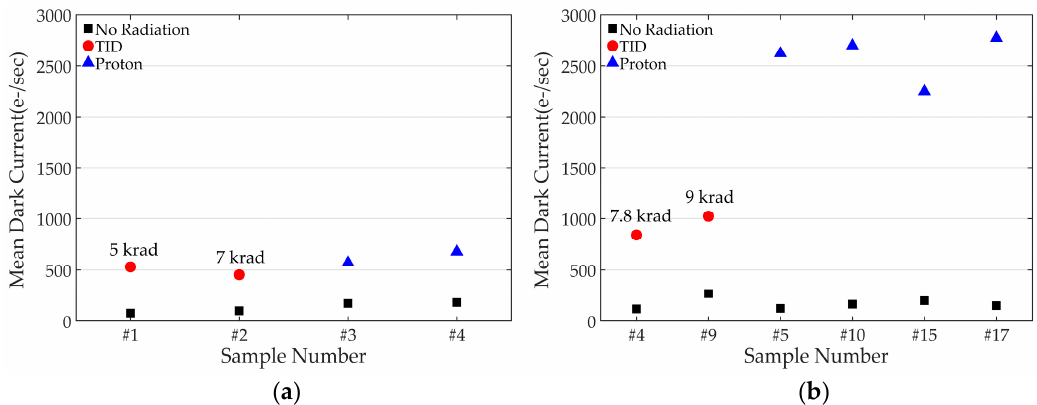
Figure 11. Radiation damage effects with two different in-pixel MOS capacitors: ( a ) 16.3 fF MOS capacitor ( b ) 19.6 fF MOS capacitor.